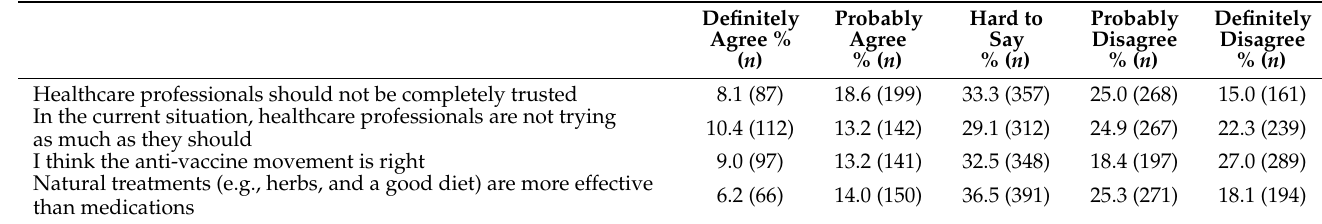
Table 1. Distributions of responses to statements used to create the trust index ( n =